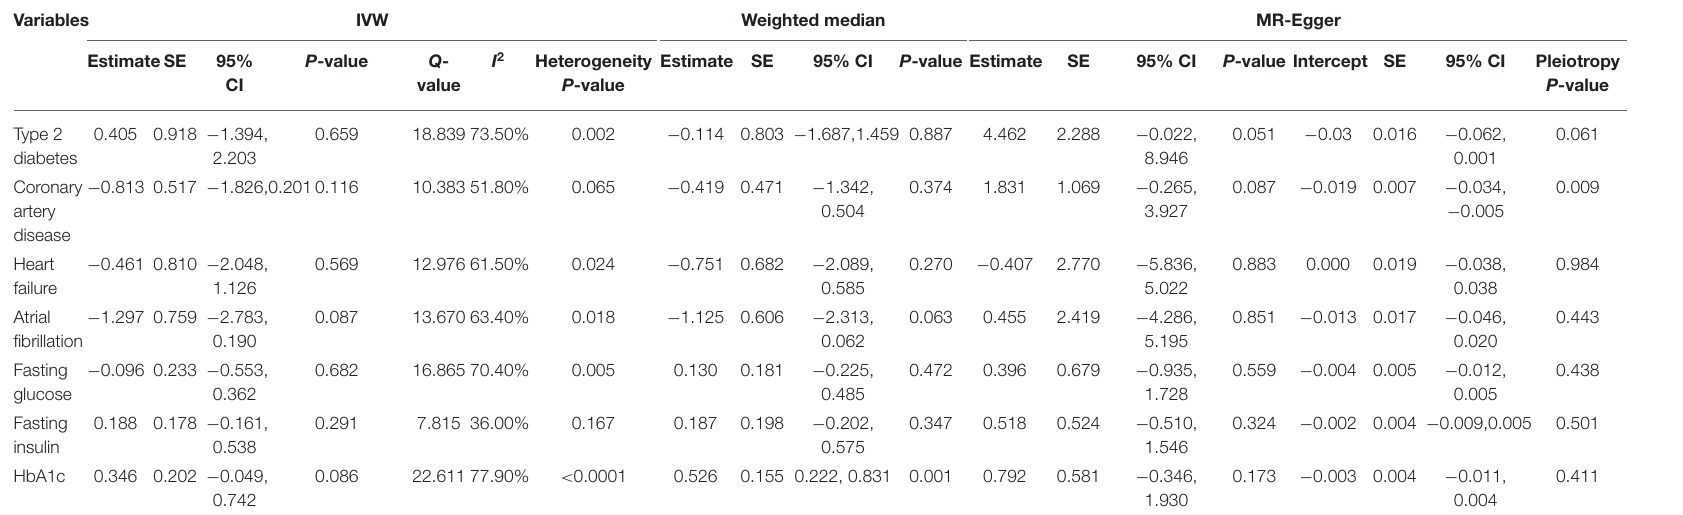
TABLE 3 | Mendelian randomization estimates of serum magnesium on cardiometabolic